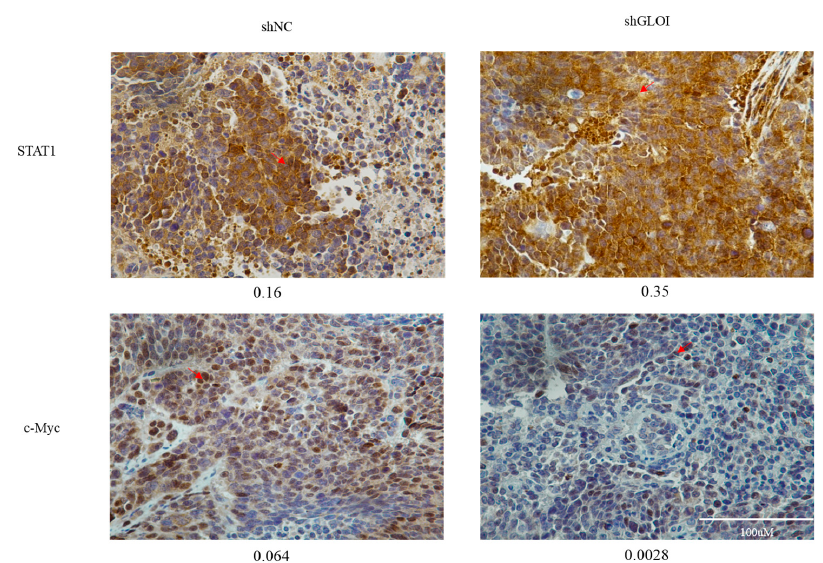
Figure 11. GLOI knockdown alters STAT1 and c-Myc expression in SW620 colorectal xenograft tumors. STAT1 and c-Myc expression was determined by immunohistochemical staining of SW620 tumors generated by injecting BALB/c nude mice with SW620 cells transfected with shGLOI or shNC (empty vector). Representative images are shown (original magnification, ×400). The arrow is pointing at positive cells. The integrated optical density (IOD) of STAT1 and c-Myc positive cells was determined in the CRC tumor tissue and indicated under each image. The arrow pointed at STAT1 or c-Myc expression positive cells in the CRC tumor tissue.